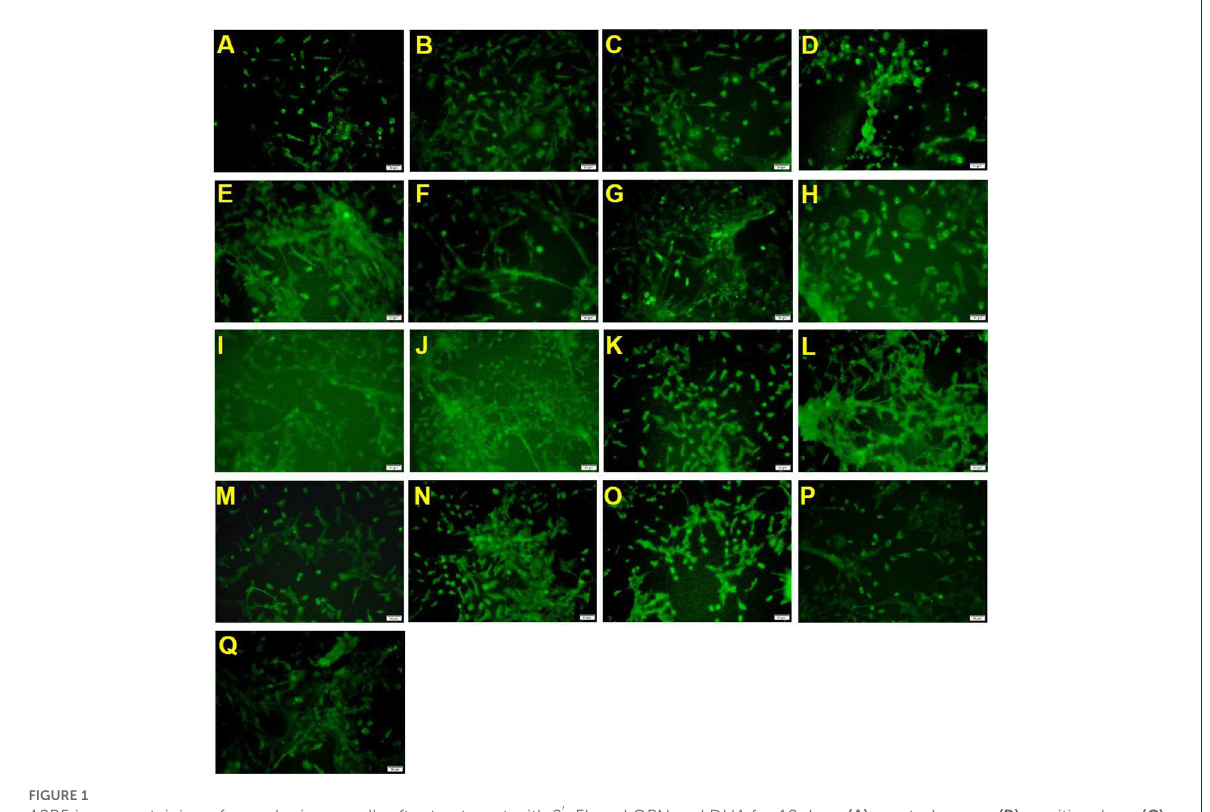
FIGURE1 A2B5 immunostaining of neural primary cells after treatment with 2 ′ -FL and OPN and DHA for 12 days. (A) , control group; (B) , positive drug; (C) , 2 ′ -FL(H); (D) , OPN(H); (E) , DHA(H); (F) , 2 ′ -FL(L) + OPN(L); (G) , 2 ′ -FL(L) + OPN(H); (H) , 2 ′ -FL(M) + OPN(M); (I) , 2 ′ -FL(H) + OPN(L); (J) , 2 ′ -FL(H) + OPN(H); (K) , 2 ′ -FL(LM) + OPN(LM); (L) , 2 ′ -FL(MH) + OPN(MH); (M) , 2 ′ -FL(L) + OPN(L) + DHA(L); (N) , 2 ′ -FL(L) + OPN(M) + DHA(M); (O) , 2 ′ -FL(H) + OPN(H) + DHA(H); (P) , 2 ′ -FL(LM) + OPN(LM) + DHA(LM); (Q) , 2 ′ -FL(MH) + OPN(MH) + DHA(MH). Scale bar: 50 µ